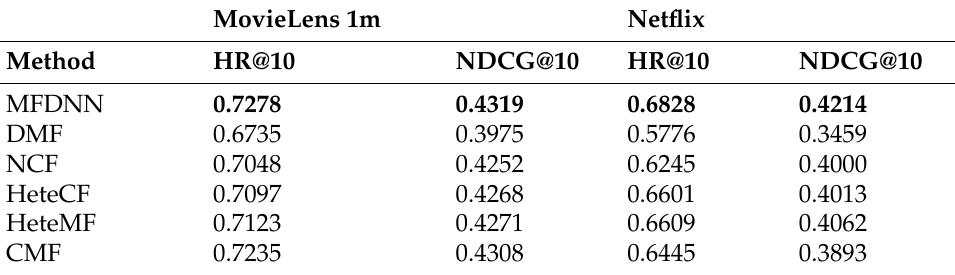
Table 4. The experimental results compared with the results from the baseline methods.